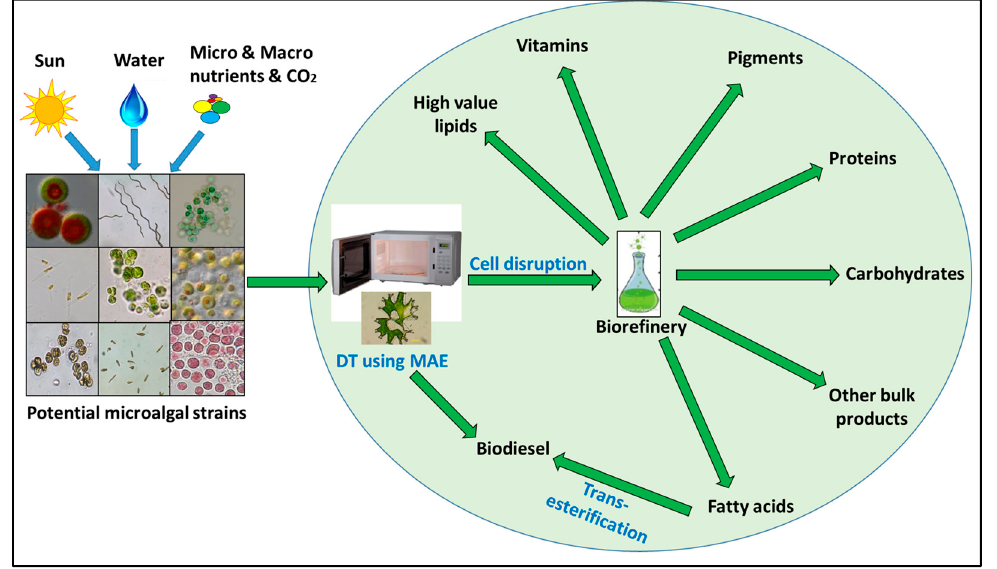
Figure 2. Overview of MAE based biorefinery for microalgal biotechnology.